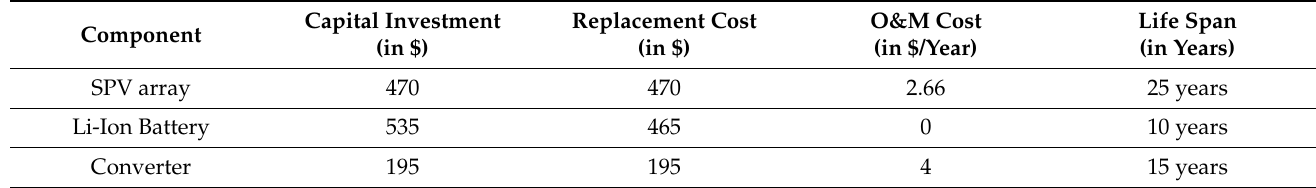
Table 5. Specifications of the components of